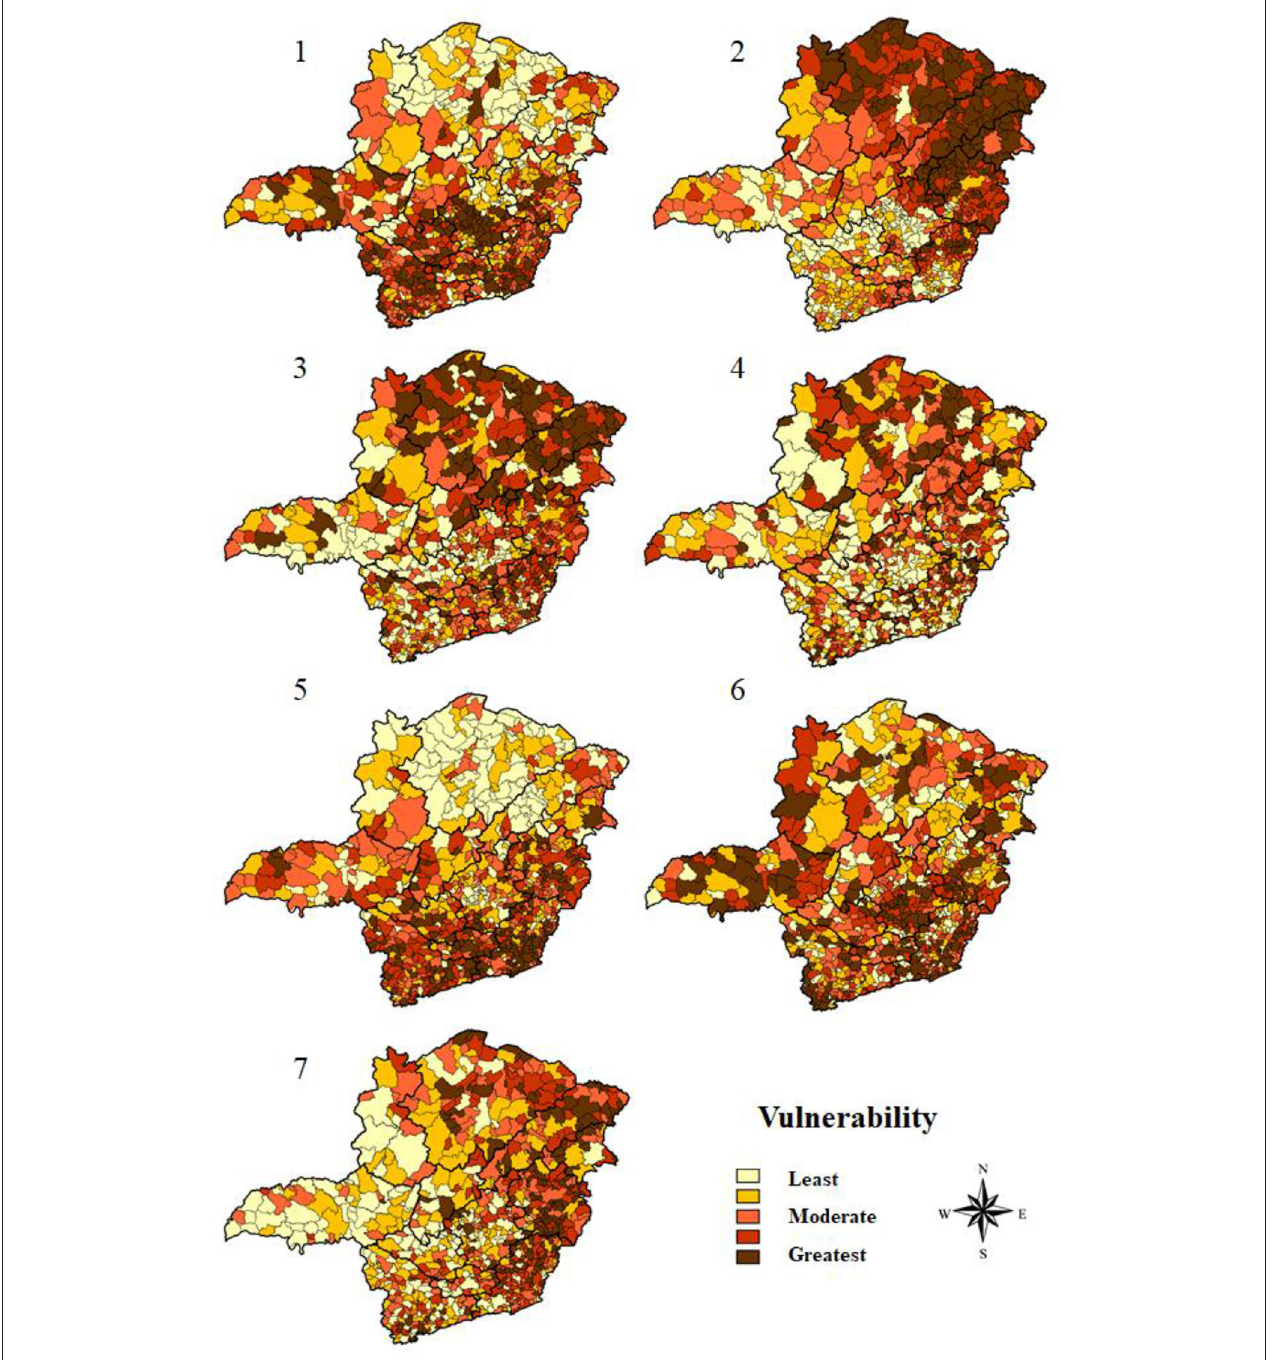
FIGURE 3 | Thematic maps of the vulnerability simulations of the municipalities of Minas Gerais for COVID-19, based on the multi-criteria decision analysis.